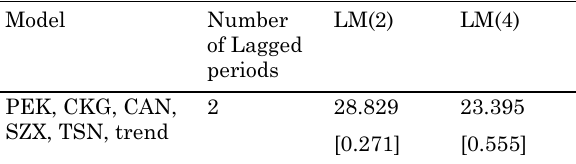
Table 6. VAR model residuals’ portmanteau test for autocorrelations